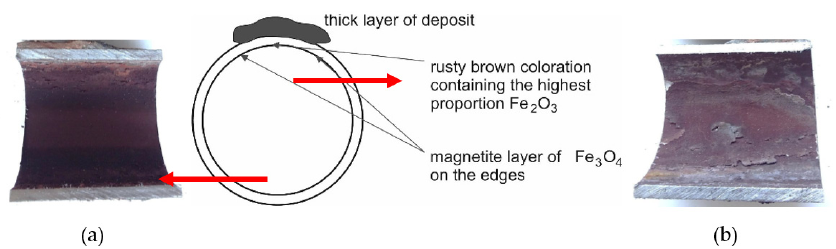
Figure 4. The inner surface of the cutout 1 tube with a massive deposit: ( a ) the lower part of the tube; ( b ) the upper part of the tube placed under the deposit layer according to Figure 3a.